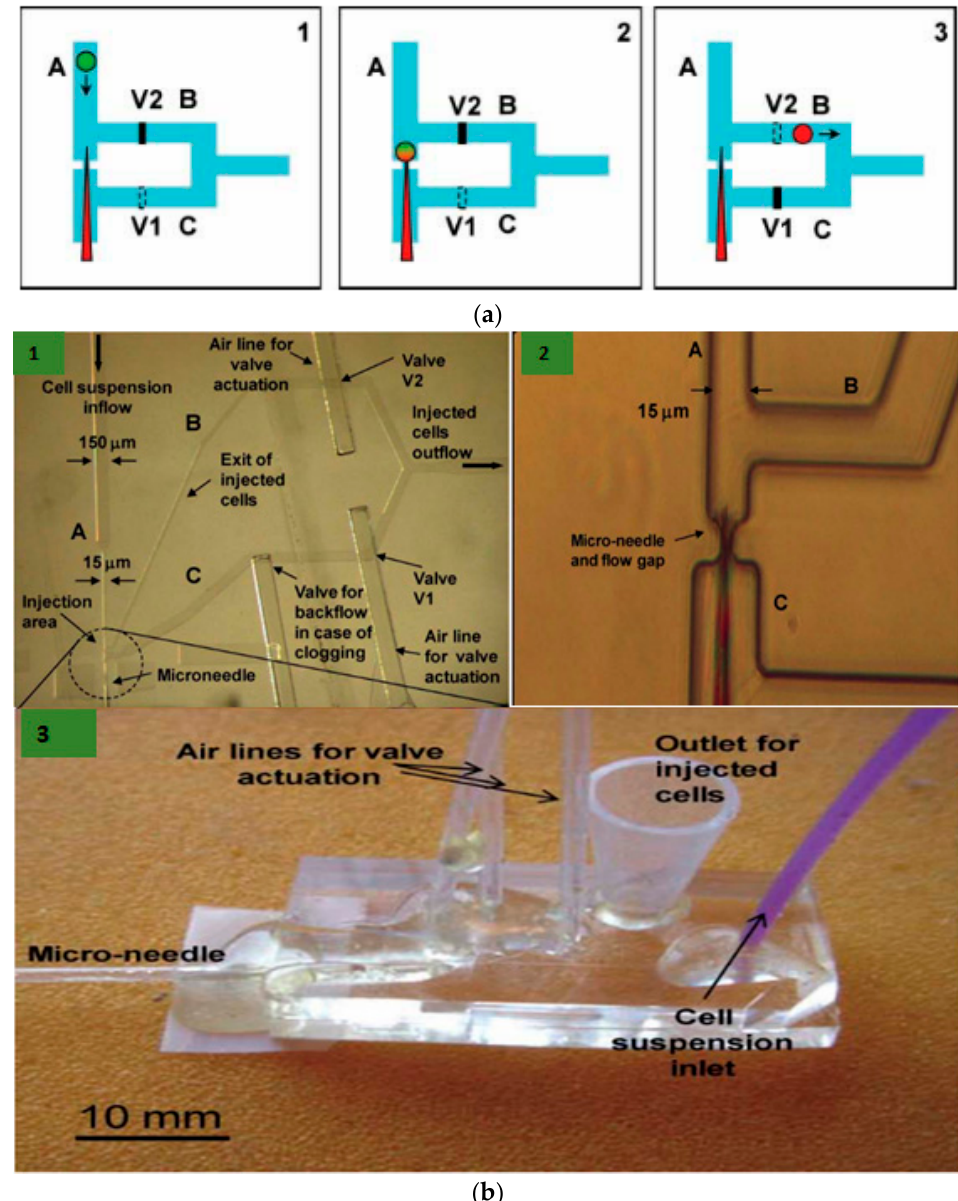
Figure 1. ( a ) Schematic diagram of the microfluidic device based on microinjection system at the single-cell level. ( 1 ) The fluid stream transports the cell to be injected to a microneedle and valve 1 (V1) is open while valve 2 (V2) is closed. ( 2 ) The needle helps in piercing the cell and thus performs microinjection. ( 3 ) Now, V1 is closed and V2 is open. This causes the fluid stream and the volume displaced by the valve V1 process to take the cell off the needle and transport it through channel B into a reservoir. ( b ) ( 1 ) Microscopic image of the microinjection chip with channels A, B, and C; and valves V1 and V2. ( 2 ) The zoom-in image of the microinjection area where the cell is impinged by the needle. ( 3 ) Image of the developed microfluidic platform. Reprinted with permission from ref. [61]. Copyright © 2001 Royal Society of Chemistry.